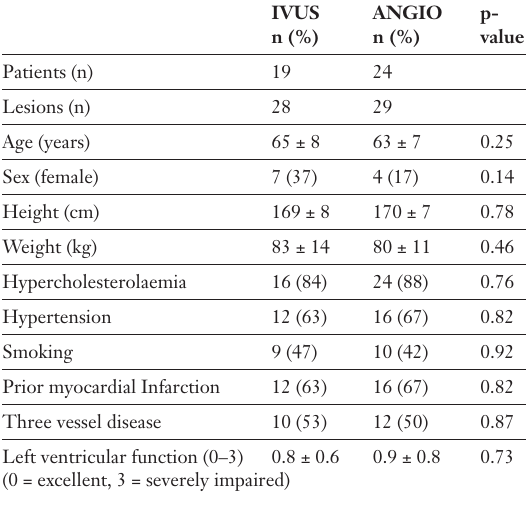
Quantitative coronary angiographic analysis in 57 target lesions before and after intervention.